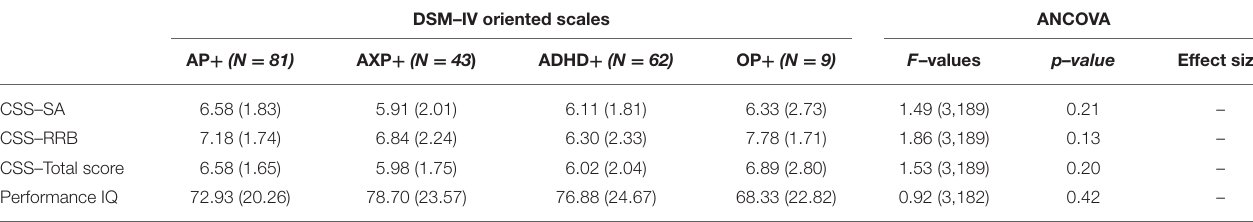
TABLE 4 | Clinical differences among group of ASD subjects with specific psychiatric mono–comorbidity.